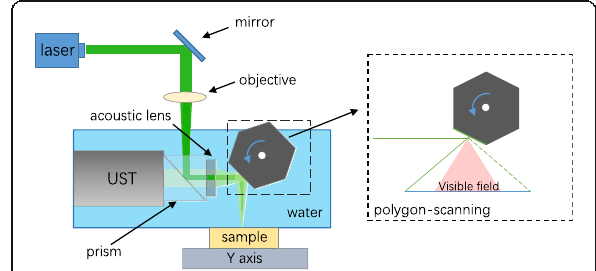
Fig. 1 System schematic. A laser at a 532 nm wavelength is coaxially coupled with an ultrasound beam through a photoacoustic prism and is reflected onto the sample by a rotating mirror. With the rotation of the rotating mirror, the position of the optical beam and sound beam reflected on the sample will change. The scanning area is divided into the visible field and invisible field